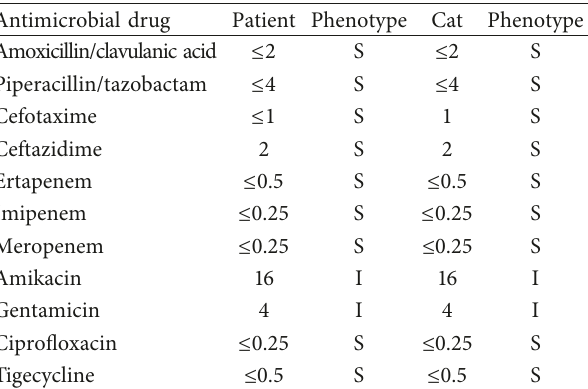
Table 1: Antibiotic sensitivity phenotype of Pasteurella multocida strains from the patient and cat, in mg/L of minimal inhibitory concentration (MIC). Antimicrobial drug Patient Phenotype Cat